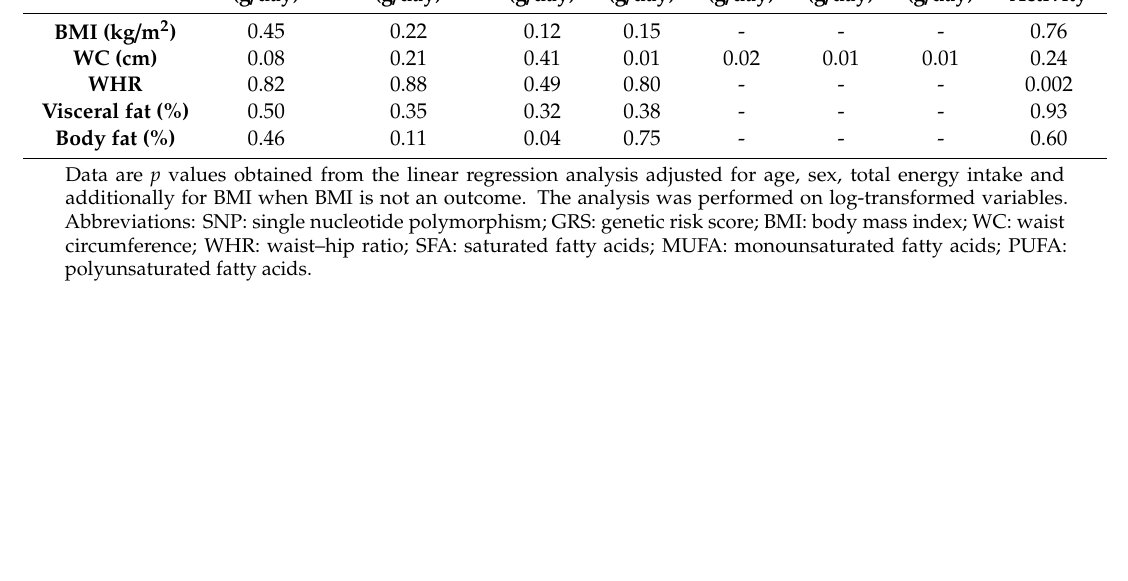
Table 3. Interactions between the 4-SNP GRS and the lifestyle factors on obesity-related traits.